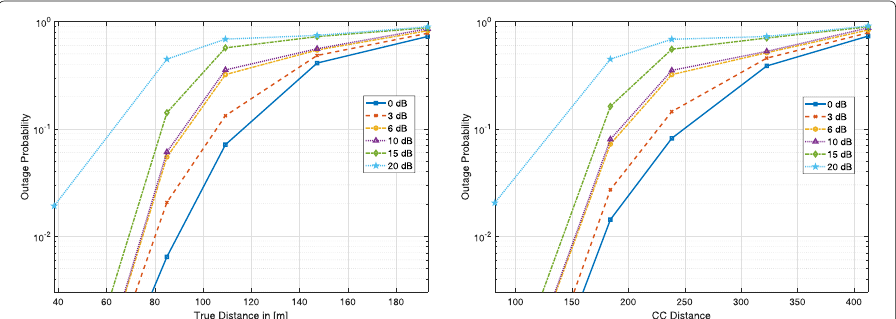
Fig. 10 Outage probability for different SNR threshold values as a function of true distance (left plot) and CC distance (right plot)